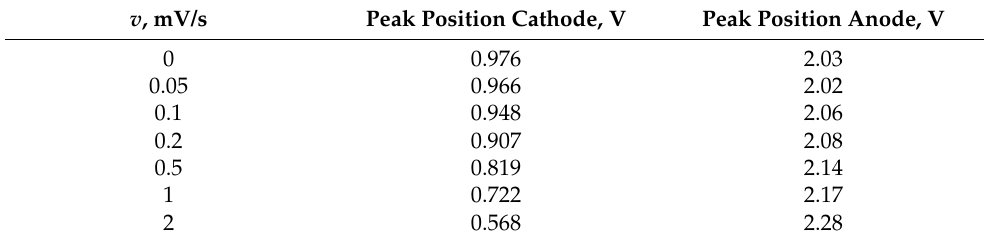
Figure 6. CVA recorded at different sweep speeds in T1 material (experiment E1): ( a ) v = 0.05–0.2 mV/s, ( b ) v = 0.5–2 mV/s. Table 4. Voltage position of C and A peaks (T1 3rd cycle).